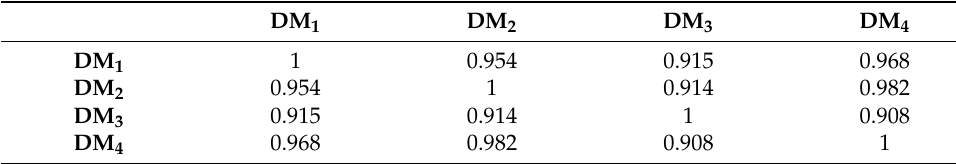
Table 4. Correlation coefficient of single-valued neutrosophic sets.